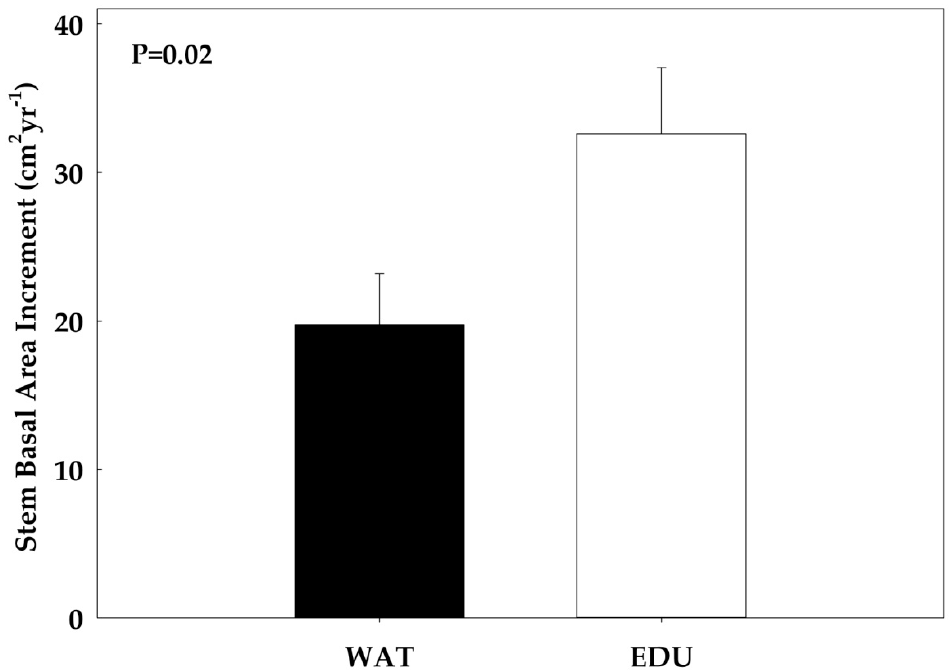
Figure 2. Mean stem basal area increment (±SD) recorded at the harvest for WAT (water treated trees) and EDU (EDU treated trees) ( N = 5). Difference between stem sapwood of 2013 and 2012 represented the stem basal increment for each tree. Significant mean differences were recorded by t -test. Overall, the cumulative sums of pentad Δ R over the season resulted in a typical S-shaped curve